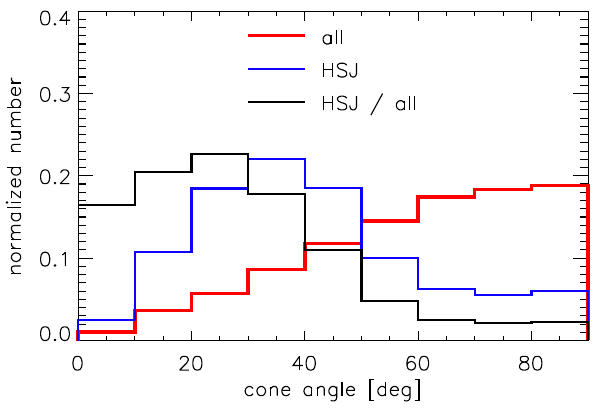
Fig. 8. Distributions of IMF cone angles for HSJ t 0 times (blue) as well as for intervals of magnetosheath measurement availability (red). The ratio of the former and latter distributions (normalized HSJ IMF cone angle distribution) is shown in black.